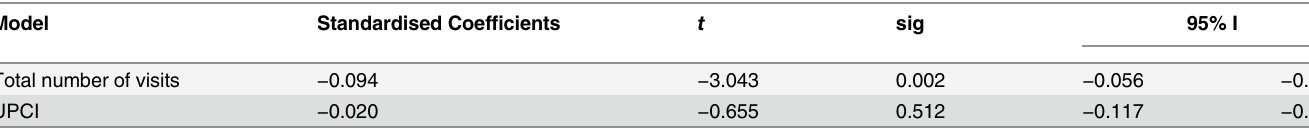
Table 4. Relationship between blood pressure control and UPCI.